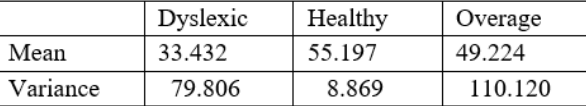
Figure 1: The proposed architecture is: